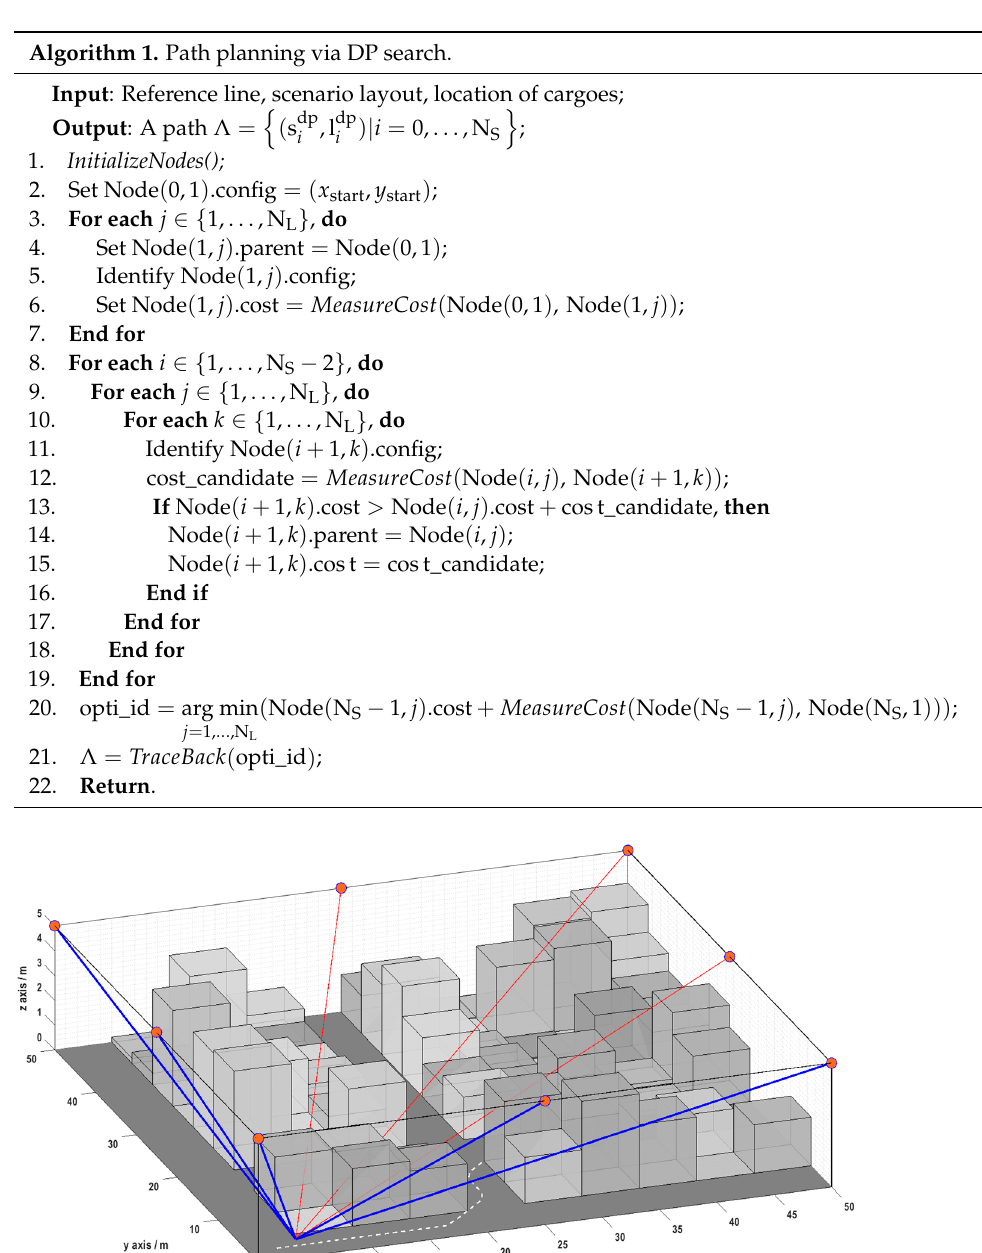
Algorithm 1. Path planning via DP search.